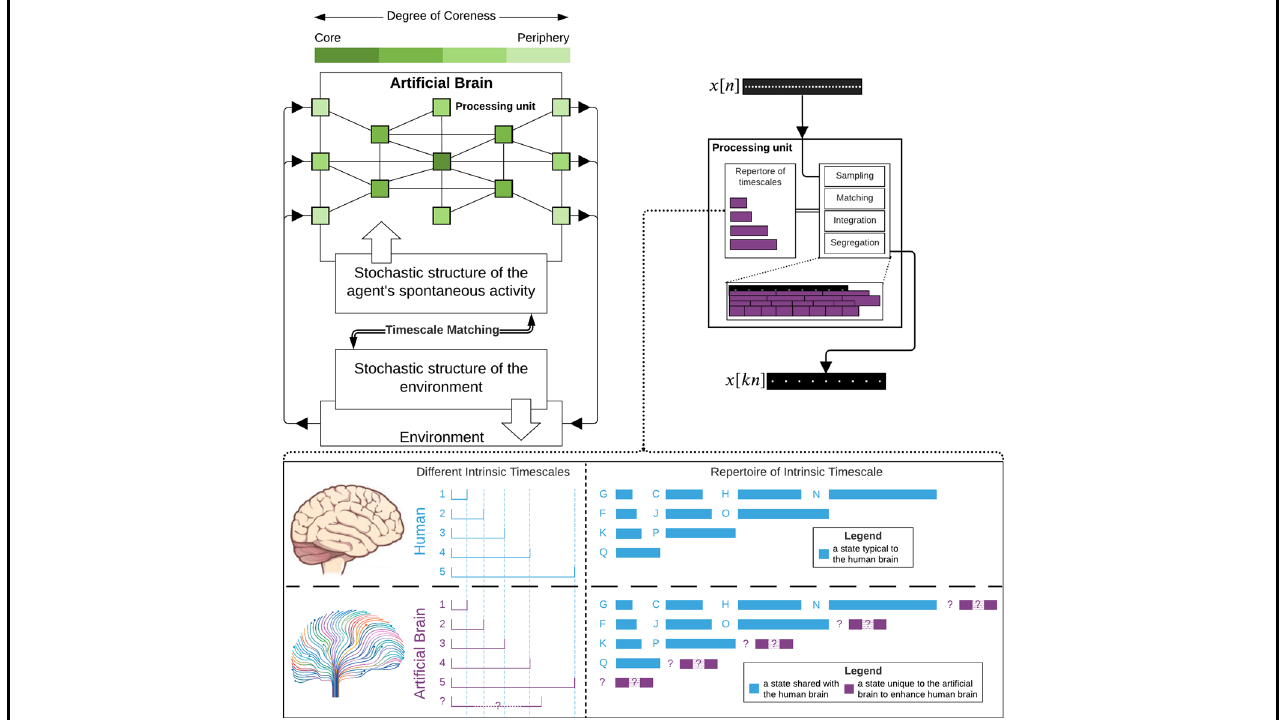
modal regions . Murray and colleagues 4 investigated single-cell recording data in non-human primates and calculated their autocorrelation function in pre-stimulus intervals. From that, they measured the duration of the temporal window at a corre- lower-order unimodal sensory regions while